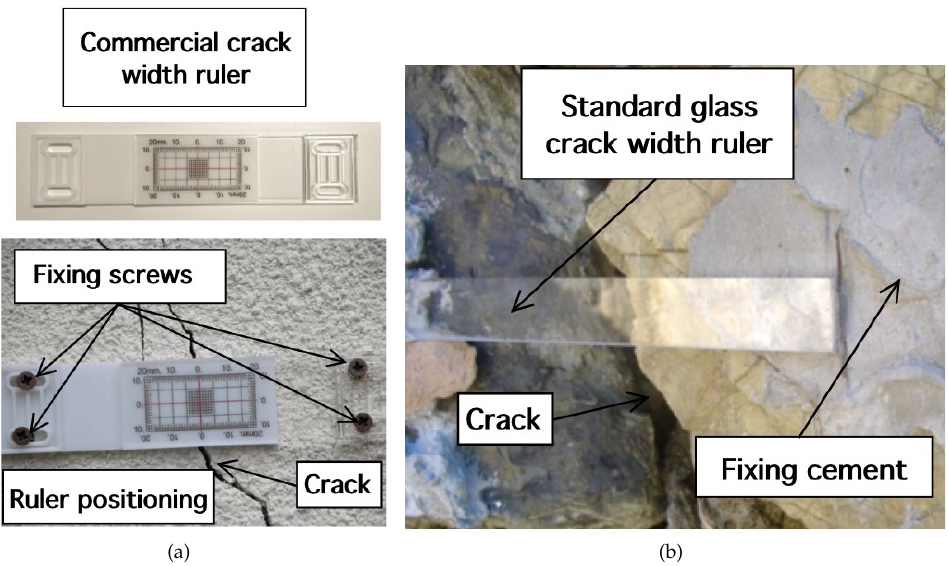
Figure 2. Crack monitoring rulers, ( a ) commercial and ( b ) standard glass ruler.